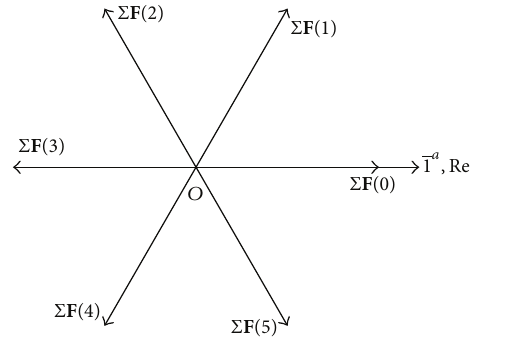
Figure 4: Vector diagram of stator current